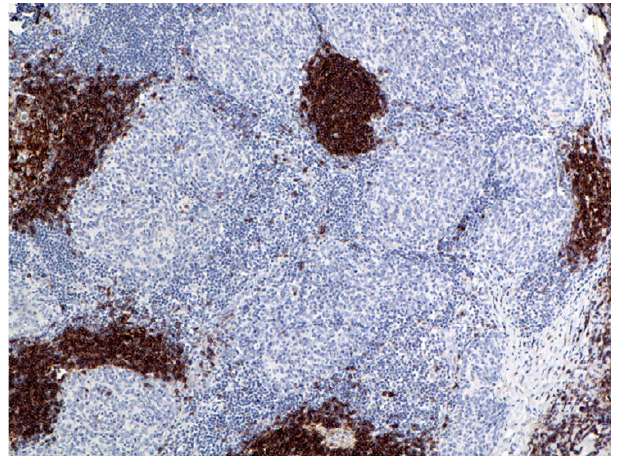
Figure 16 (B-SA, anti-CD20, × 200): Micronodular thymoma. Note large lymphoid aggregates positive for